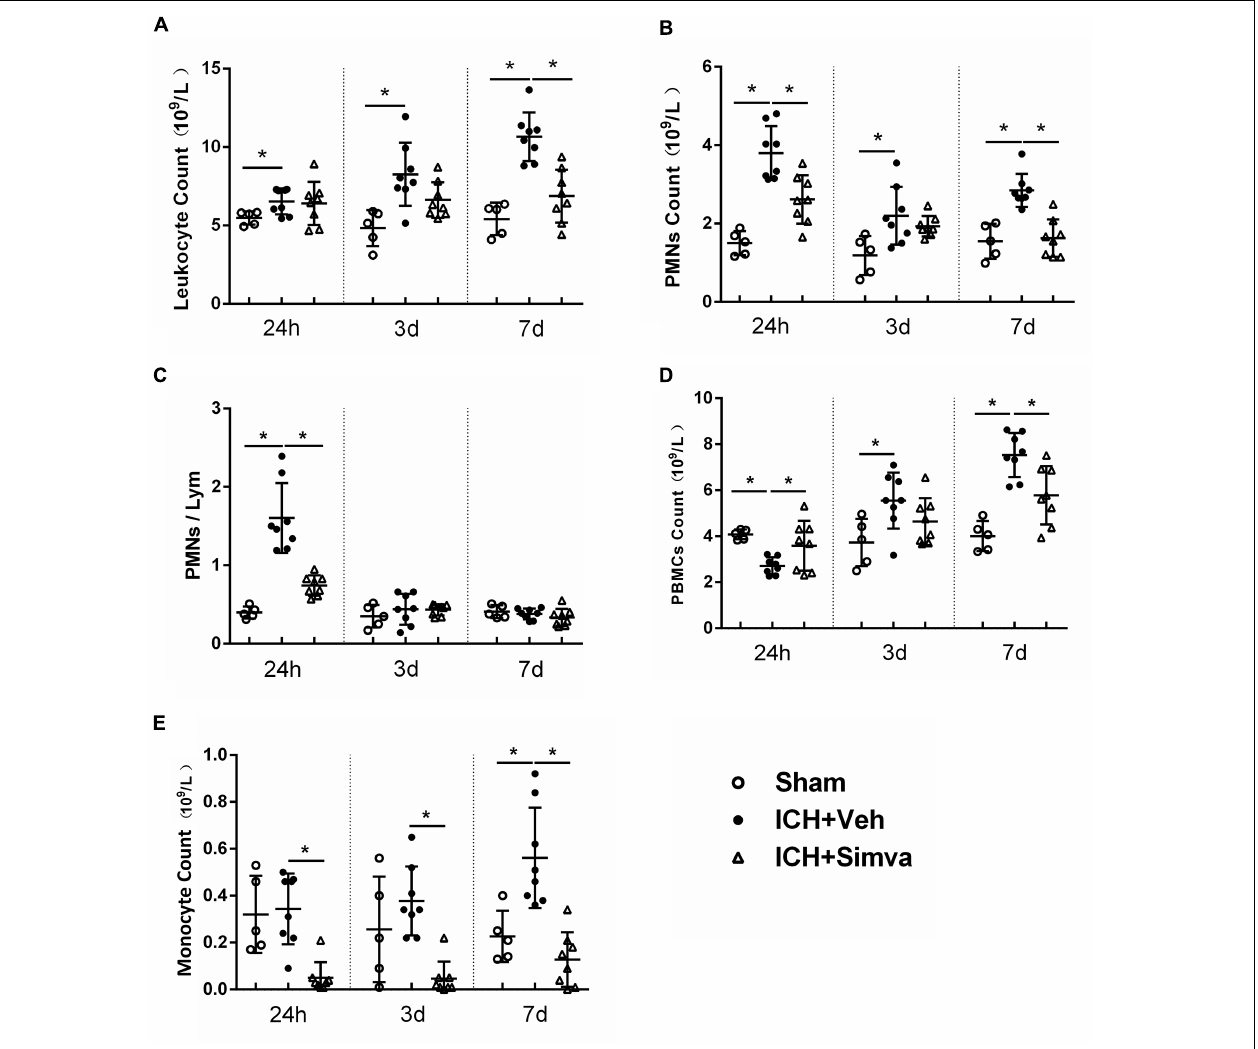
FIGURE 1 | Elevated PMNs count and NLR in circulation were detected in rat model of ICH, which was reversed by using simvastatin. Analysis of peripheral leukocyte count (A) , PMNs count (B) , NLR (C) , PBMCs count (D), and monocyte count (E) on day1, 3, and 7 days after sham operation ( n = 5 each time point), ICH+Vehicle ( n = 8 each time point), and ICH+Simvastatin ( n = 8 each time point). Values are expressed as mean ± SD; ∗ P < 0.05. ICH, intracerebral hemorrhage; PMNs, polymorphonuclear neutrophils; NLR, neutrophil to lymphocyte ratio; PBMCs, peripheral blood mononuclear cells; Lym,